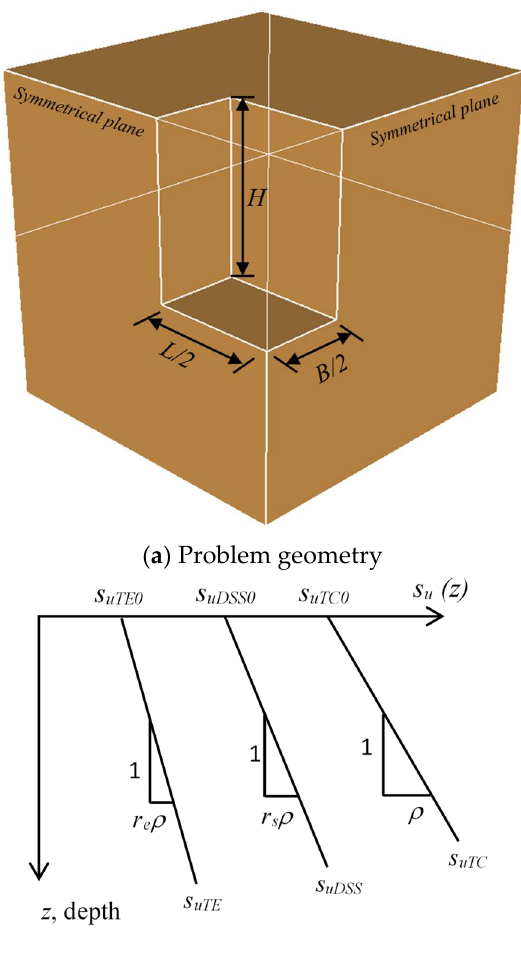
Figure 1. Statement of the problem .